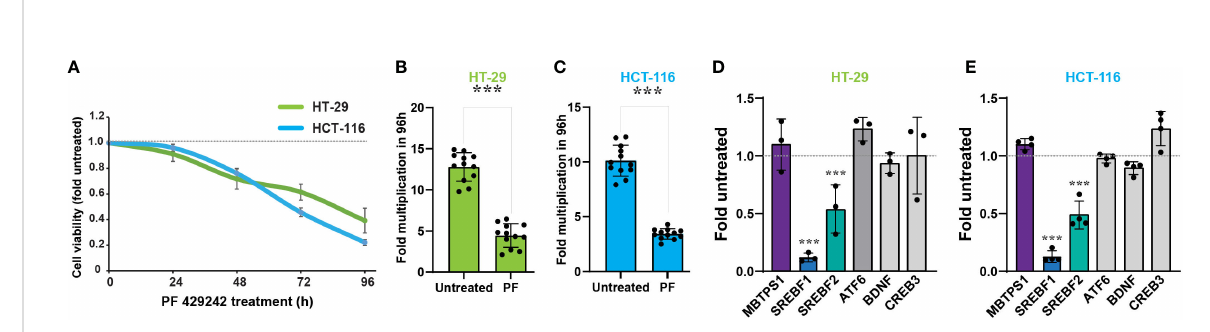
FIGURE 3 MBTPS1 is involved in proliferation of colon cancer-derived HT-29 and HCT-116 cells. (A) Inhibition of MBTPS1 enzymatic activity attenuates cell proliferation. Proliferation of HT-29 cells (green line) and HCT-116 (light blue line) treated with either vehicle or 10 m M PF-429242 for the entire duration of the experiment was measured using the XTT proliferation assay. Shown is an average ± SD of n =5 for each condition from four independent experiments. Dotted line represents proliferation of the untreated cells. (B, C) Rate of cell multiplication 96h after treatment of HT- 29 (B) or HCT-116 (C) treated with either vehicle or 10 m M PF-429242. n =12 Student ’ s t -test ***p<0.0001. (D) Relative mRNA levels of MBTPS1 and its downstream targets 24 hours following treatment with 10 m M PF-429242 in HT-29 cells (D) and HCT-116 cells (E) . The levels of each gene were compared between PF-429242-treated cells to vehicle. The experiment was conducted in n =3 biological repeats with three technical repeats in each experiment. Student ’ s t -test